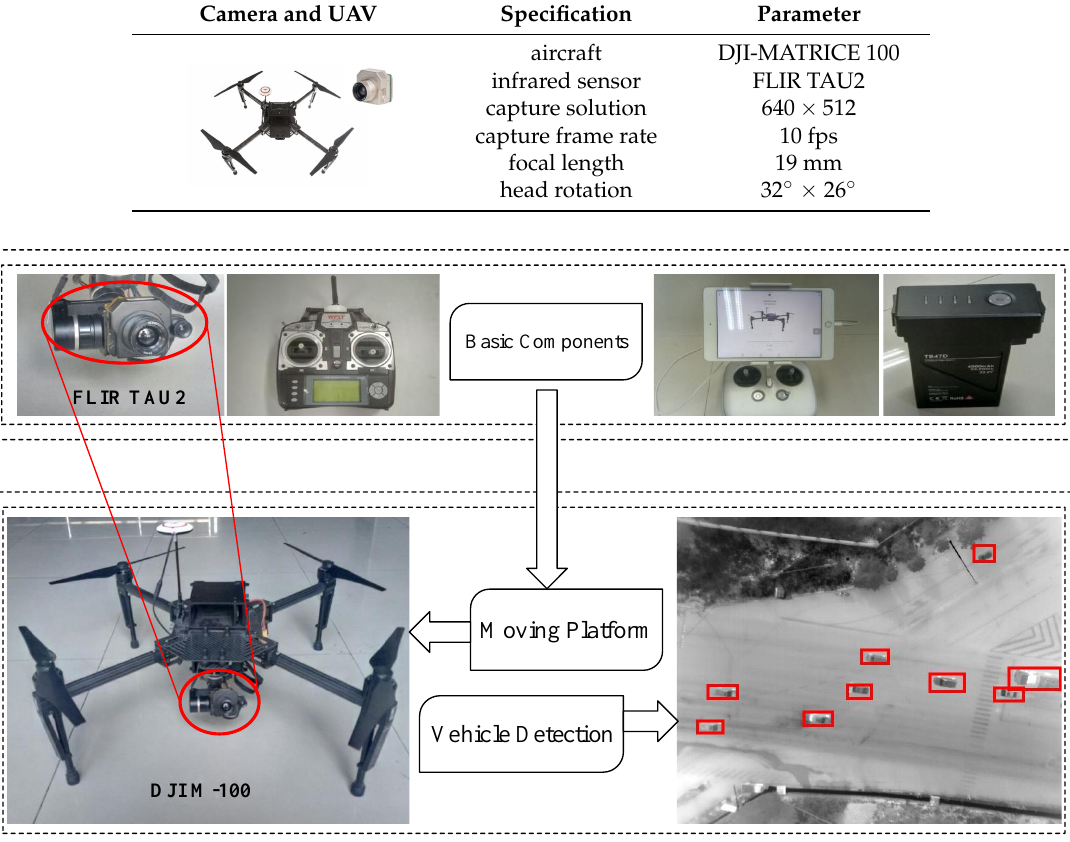
Figure 5. The real-time detection system is mainly composed of the DJI M-100, the FLIR TAU2 camera, the color model remote control, the flight remote control unit and iPad. The sensor installed on the UAV can capture the ground vehicles in real time, then transmit this information to the processor, and finally the processor shows the real-time detector on the